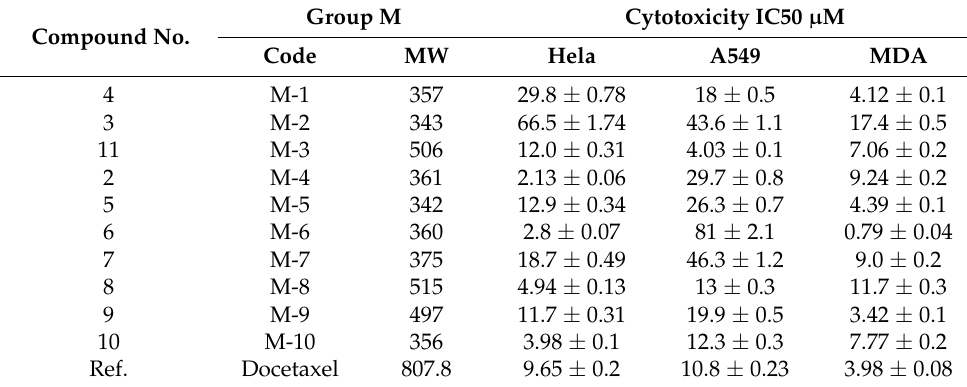
Table 2. IC50 [ µ M] values of compounds 2 – 11 and docetaxel. Group Compound No.